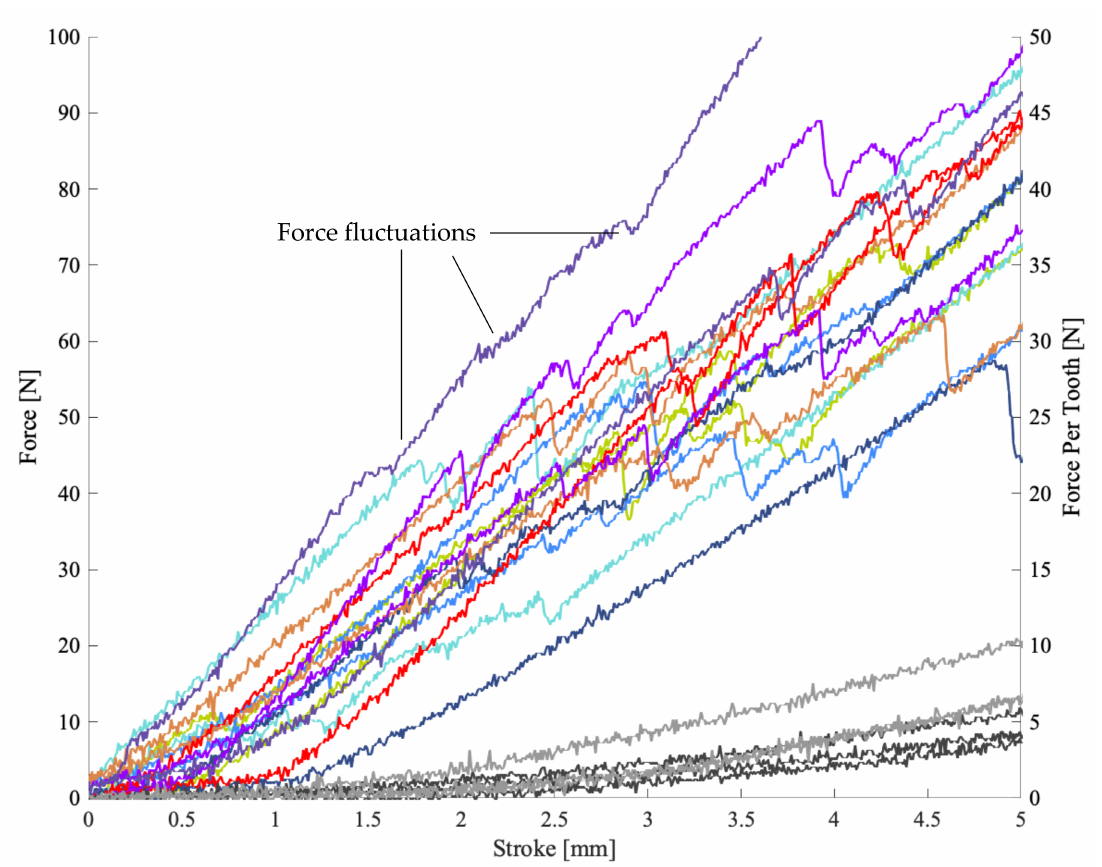
Figure 5. Magnified force–stroke